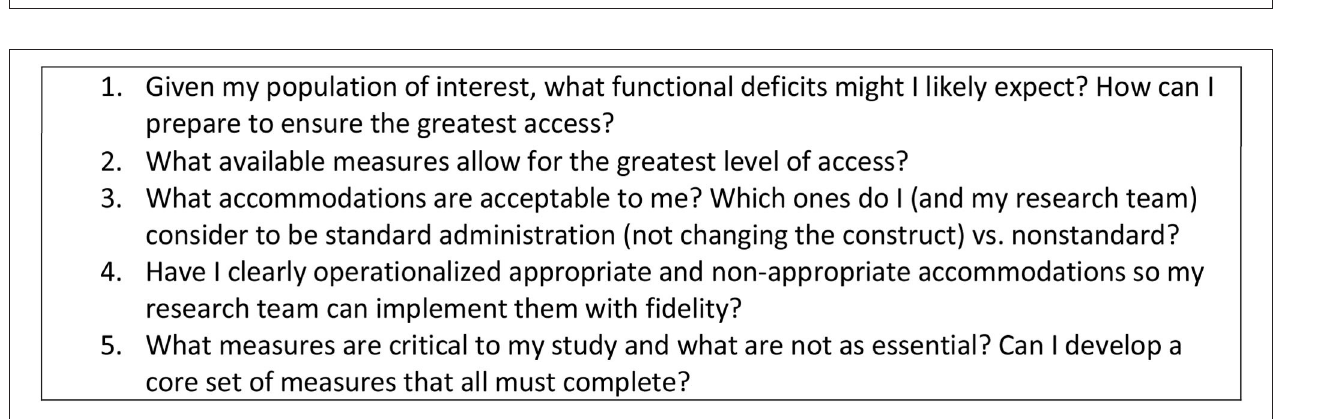
FIGURE 4 | Accessibility questions for